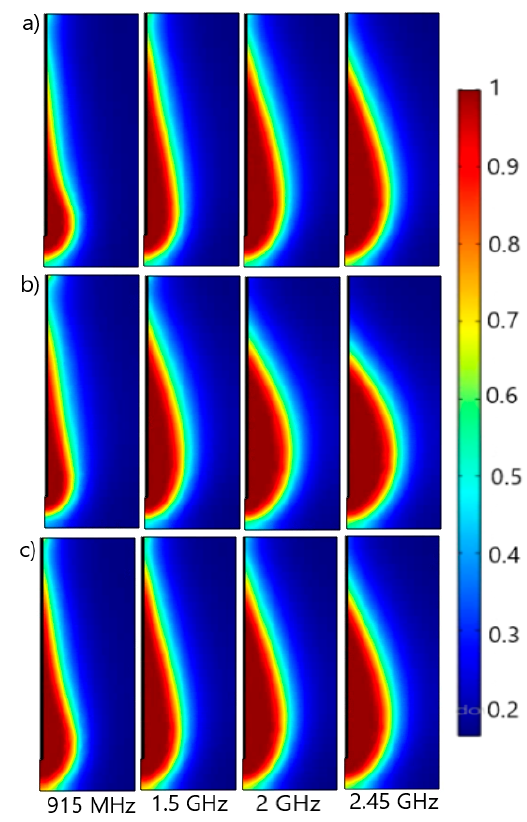
Figure 7. Fraction of necrotic tissue obtained with dielectric constants for the ( a ) inflated lungs [52], ( b ) deflated lungs [52], and ( c ) constant values [53,54], after 600 s of exposure to a frequency between 915 MHz and 2.45 GHz.